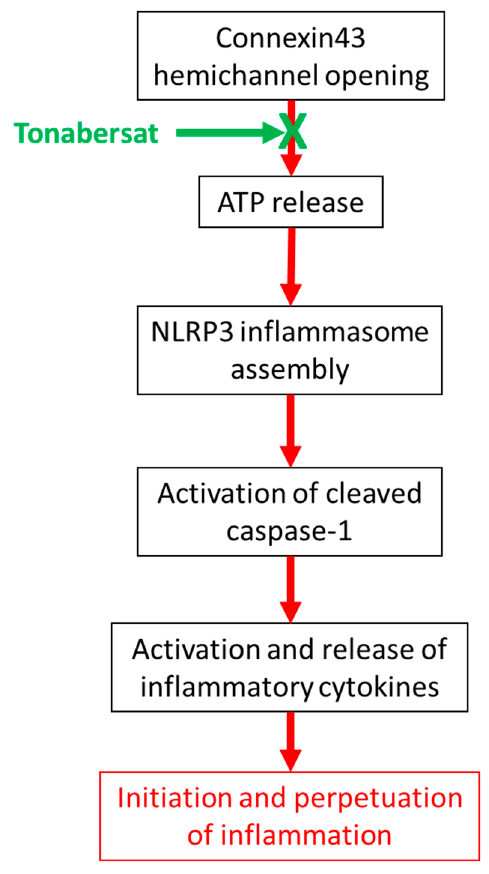
Figure 5. A schematic diagram outlining the mode of action of tonabersat. Connexin hemichannel- mediated ATP release triggers inflammasome complex assembly. Block of the connexin43 hemichannel with tonabersat prevents NLRP3 and cleaved caspase-1 complex formation and the release of inflammatory cytokines.